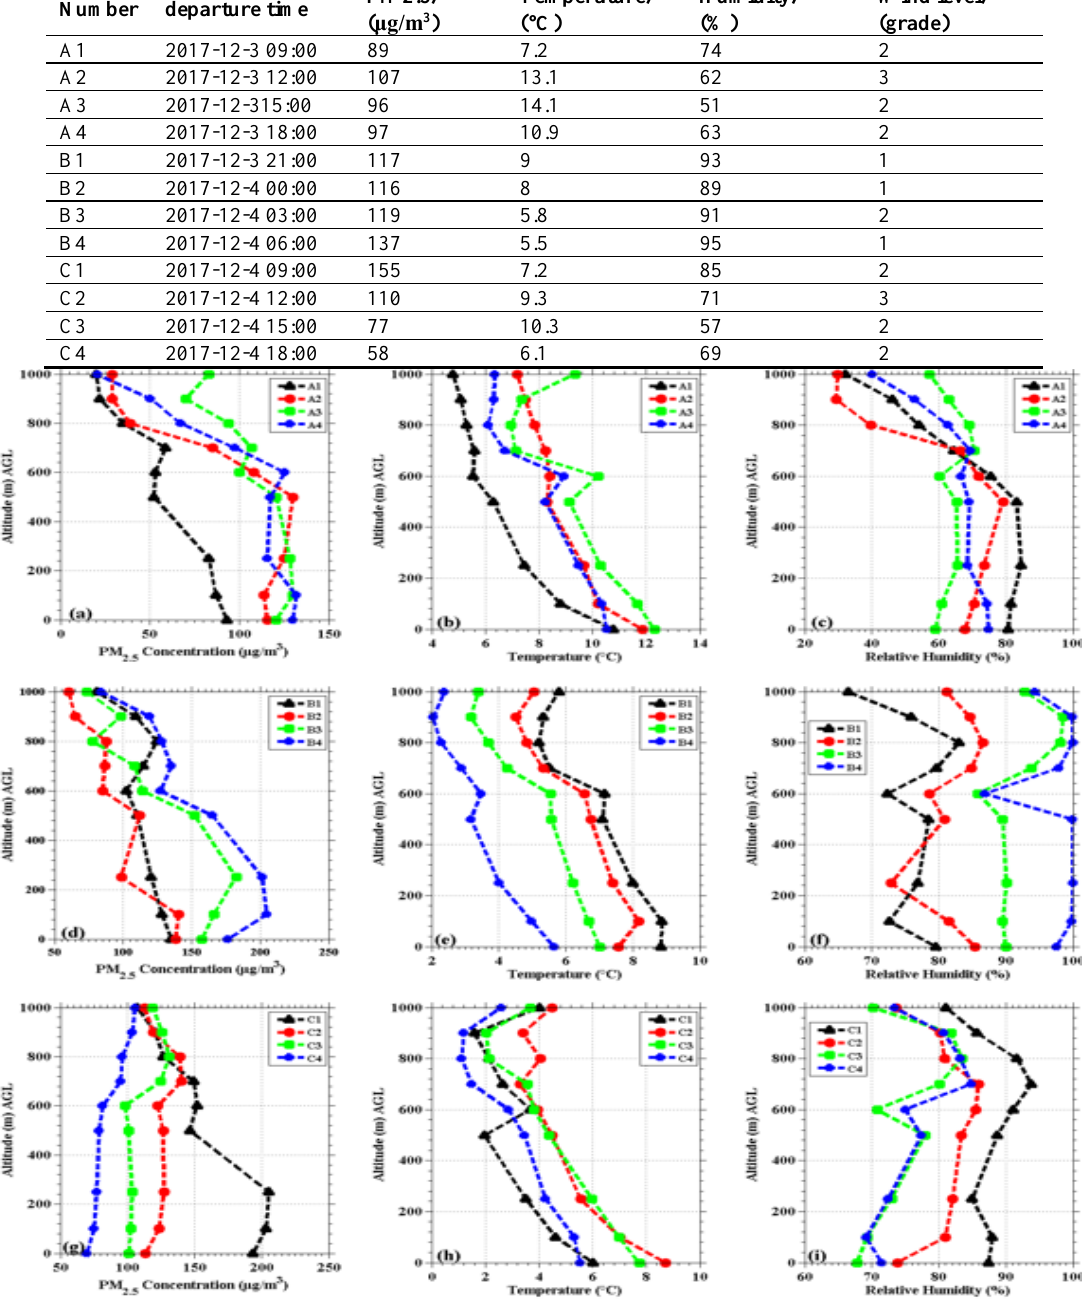
Figure 6 Vertical profile of PM2.5 concentration, temperature and relative